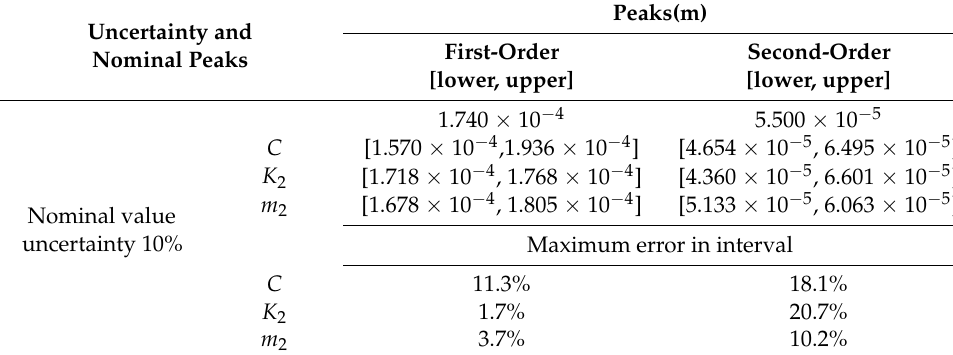
Table 3. Calculation of peaks under different uncertainty parameters.